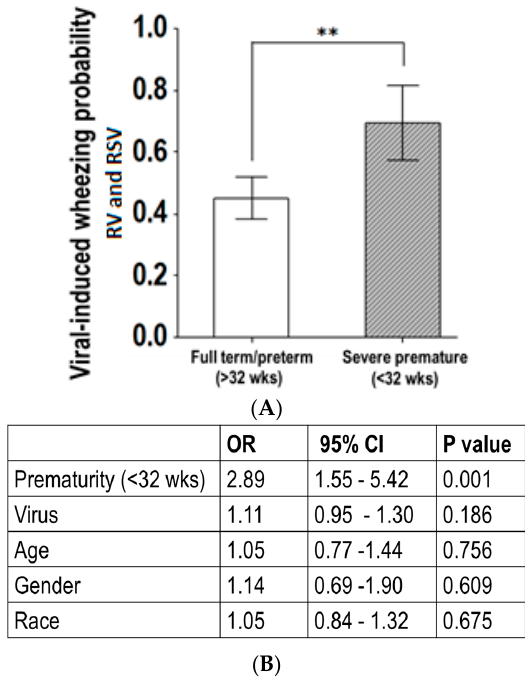
Figure 4. Age ‐ related effect of viral ‐ induced wheezing in severe prematurity. ( A ) Bars (95% CI of the mean) show the probability of virus ‐ induced wheezing was overall higher in severely premature children less than three years old; ** p < 0.01; ( B ) Multivariate logistic regression identified the link between RV ‐ or RSV ‐ induced wheezing and severe prematurity was independent of gender, race and viral pathogen identified.